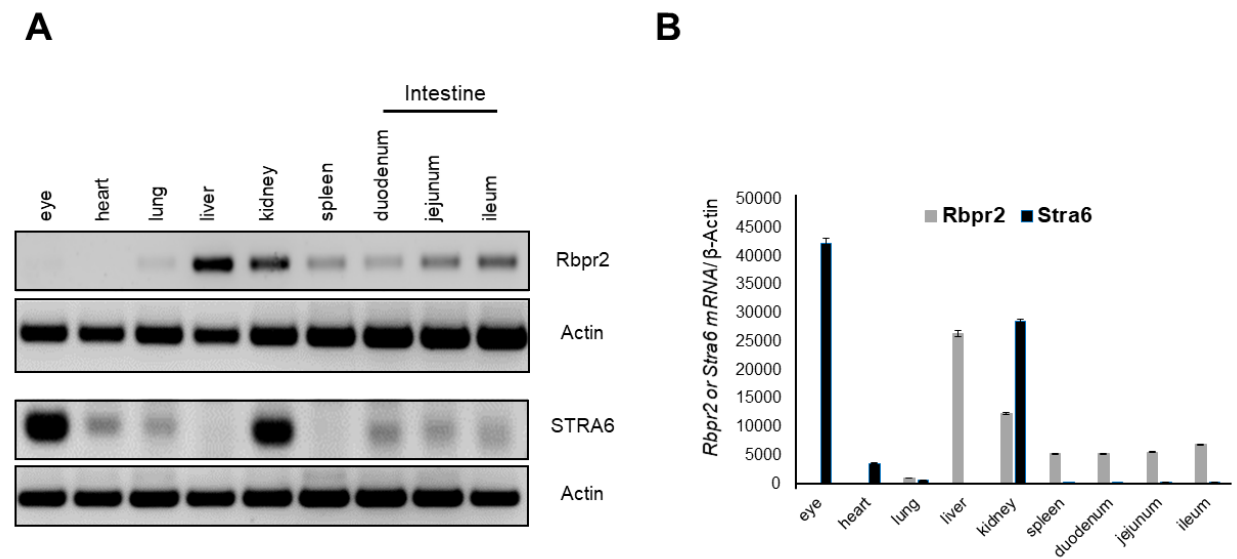
Figure 2. Rbpr2 and Stra6 mRNA expression in tissues of adult mice. ( A ) Tissues were harvested from adult wild-type (WT) mice ( n = 3). Total RNA was isolated and pooled together, respectively. Semi-quantitative RT-PCR analysis for Rbpr2 and Stra6 mRNA expression was performed using β -actin as the loading control and the respective gene-specific primers. ( B ) Numbers on the ordinate represent Rbpr2 and Stra6 mRNA expression levels normalized to mouse β -actin and expressed as mean ± SEM.